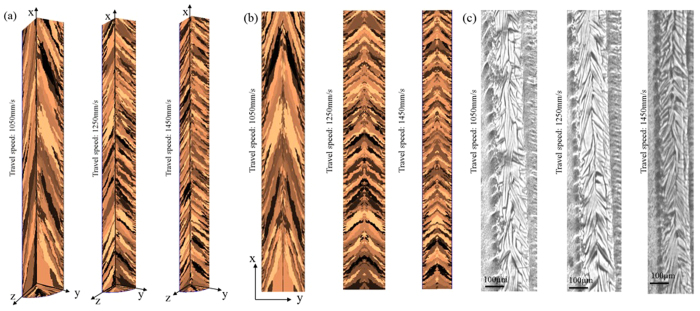
Grain structures of Ti-6Al-4V after laser-metal interaction at various laser scanning speeds.(a) 3D simulated grain structure, (b) 2D simulated grain structure in XY plane (Top view), (c) Experimental grain structure in XY plane.